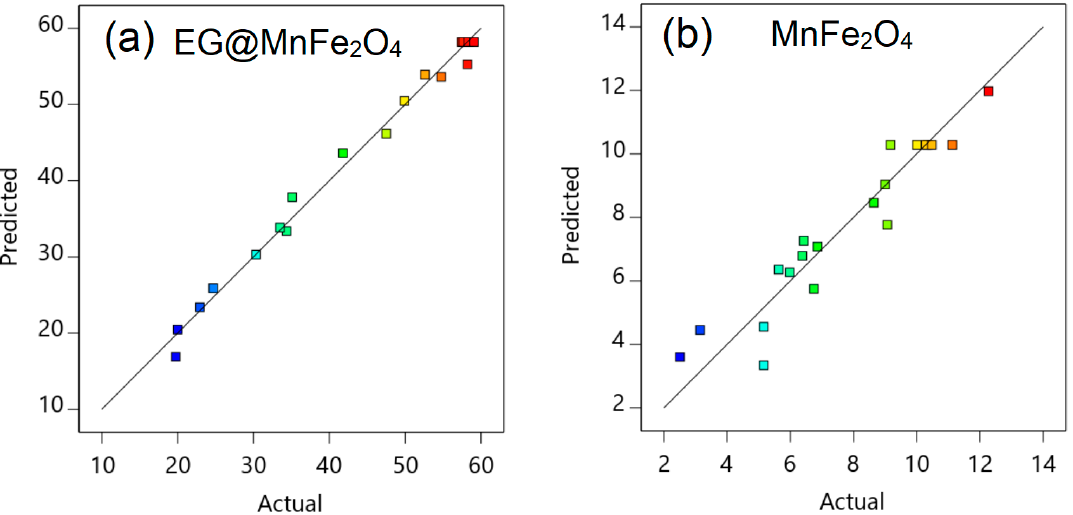
Figure 8. Actual versus predicted ( a,b ) plots for the adsorption of CR onto EG@MnFe 2 O 4 ( a ) and MnFe 2 O 4 ( b ).